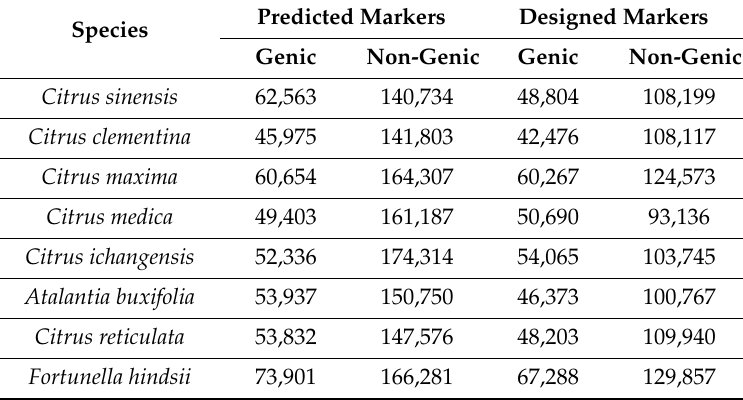
Table 5. Distribution of SSRs in the individual Citrus genome.